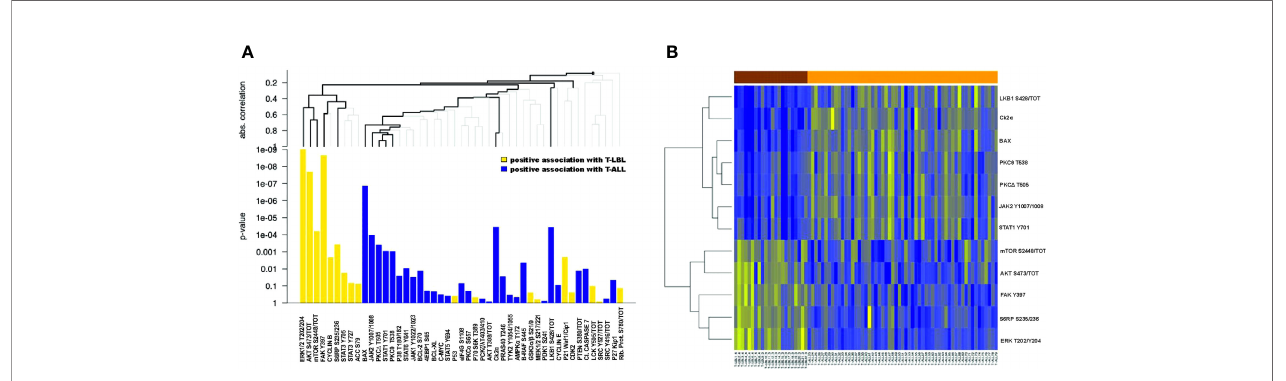
FIGURE 1 | Differentially expressed proteins between T-LBL and T-ALL samples. (A) Hierarchical clustering graph (HCG) of all proteins, where black bold lines highlight those proteins being most signi fi cantly associated with T-LBL or T-ALL. Proteins are ordered by following the HCG, where the clustering method is the average linkage and the distance measure used for the graph is the absolute correlation distance. Positive association with T-LBL (or T-ALL) refers to hyperactivated proteins in T-LBL (or in T-ALL). (B) Heatmap of the ten most differentially expressed proteins between T-LBL and